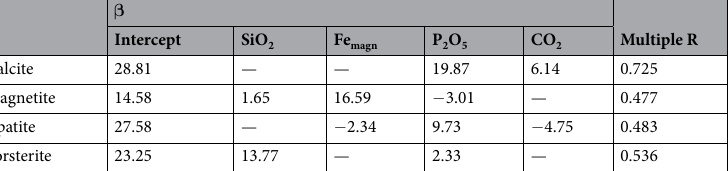
Table 2. Multiple regression for prediction of the mineral contents by bulk-rock chemistry of the Kovdor phoscorite-carbonatite